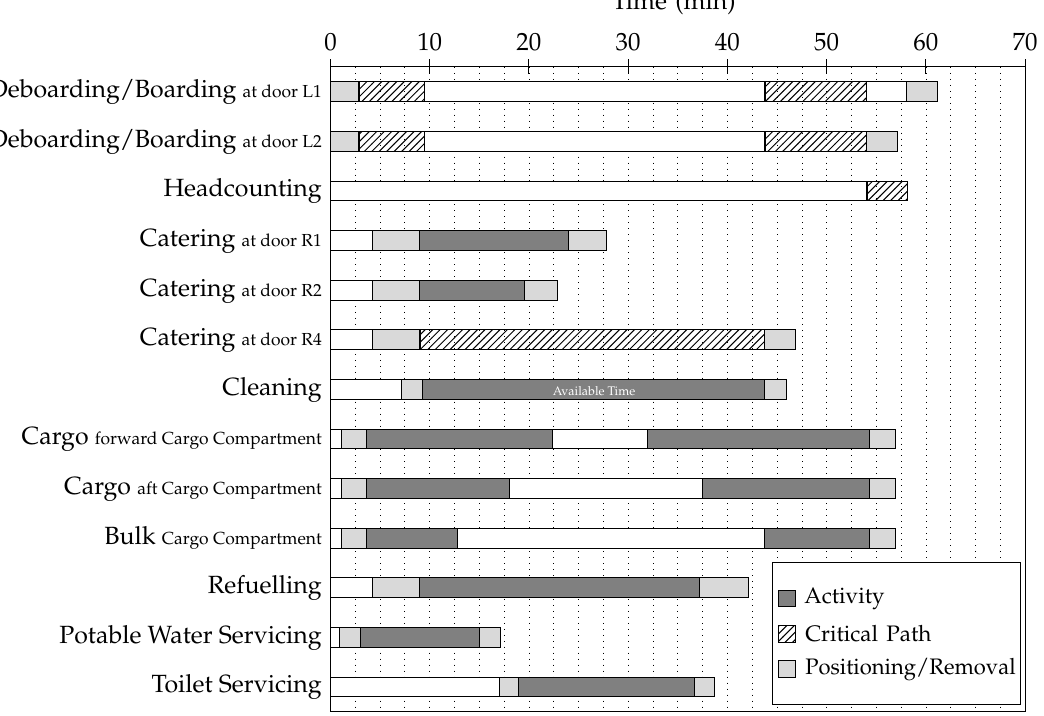
Figure 2. Turnaround Gantt Chart of the A350-900. Data from